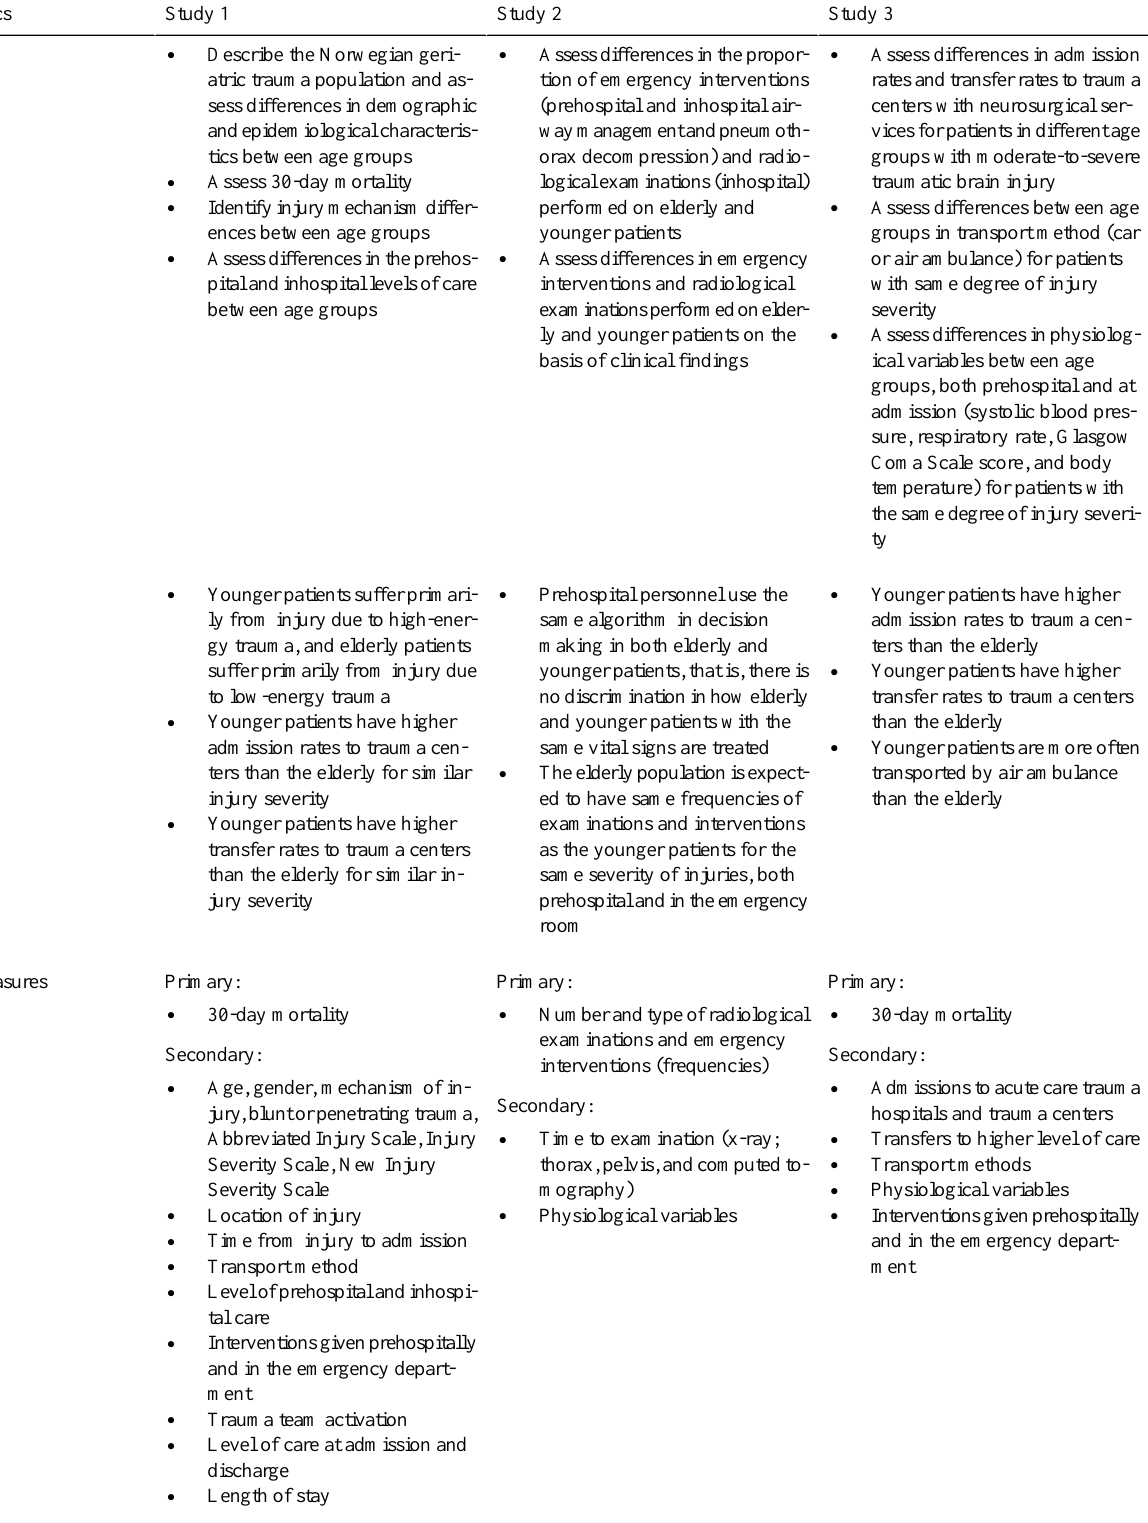
Table 1. Overview of the quantitative